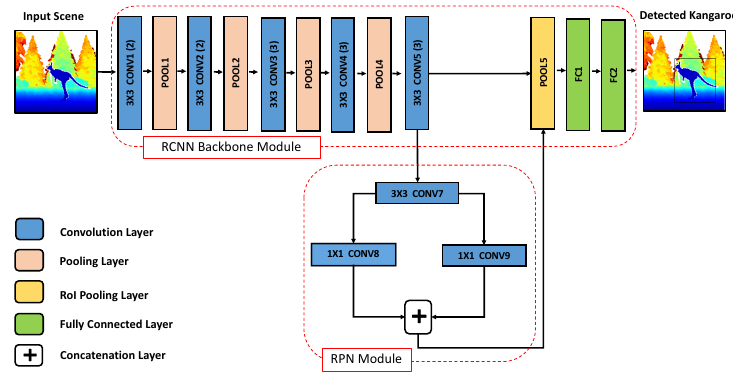
Figure 3. Proposed faster region-based convolutional neural network framework for the kangaroo detection task. The network’s input is a colorized depth image of size (640 W × 480 H × 3). The network output is the coordinates of the the localized bounding boxes of each kangaroo instance in the